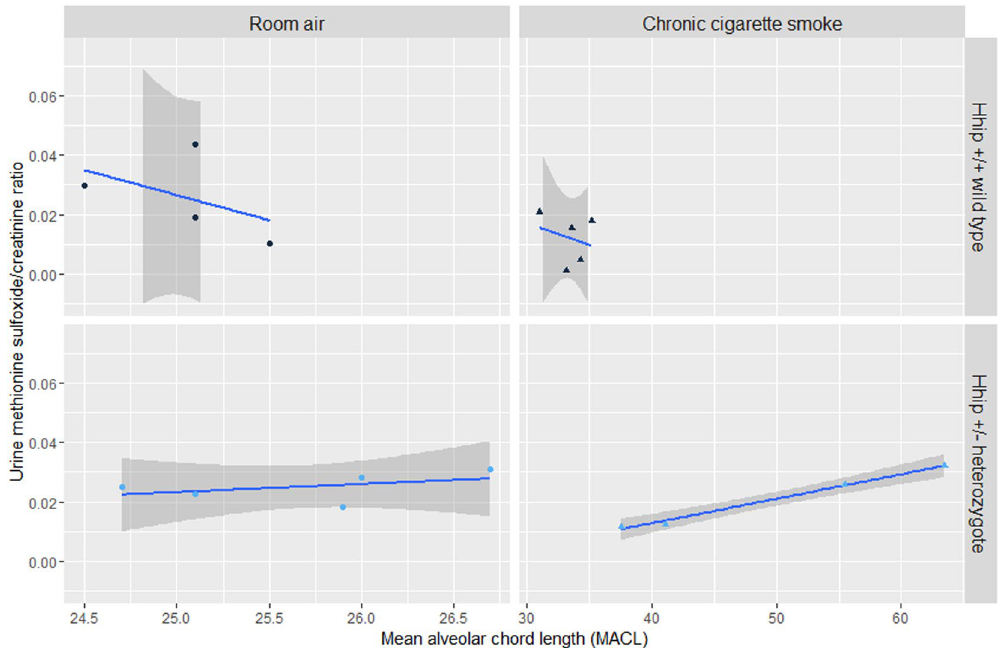
Figure 4. Association between urinary methionine sulfoxide/creatinine ratio and lung mean alveolar chord length (MACL). A significant association between urinary methionine sulfoxide/creatinine was noted in Hhip + / − heterozygotes exposed to chronic cigarette smoke (CS) (lower right panel, Pearson’s rho = 0.99, p-value = 3.94 × 10 –3 ). No association was observed in Hhip + / − mice exposed to room air or in Hhip + / + wild type mice in either experimental condition. The best fit line is plotted in blue while the 95% confidence interval is plotted in dark